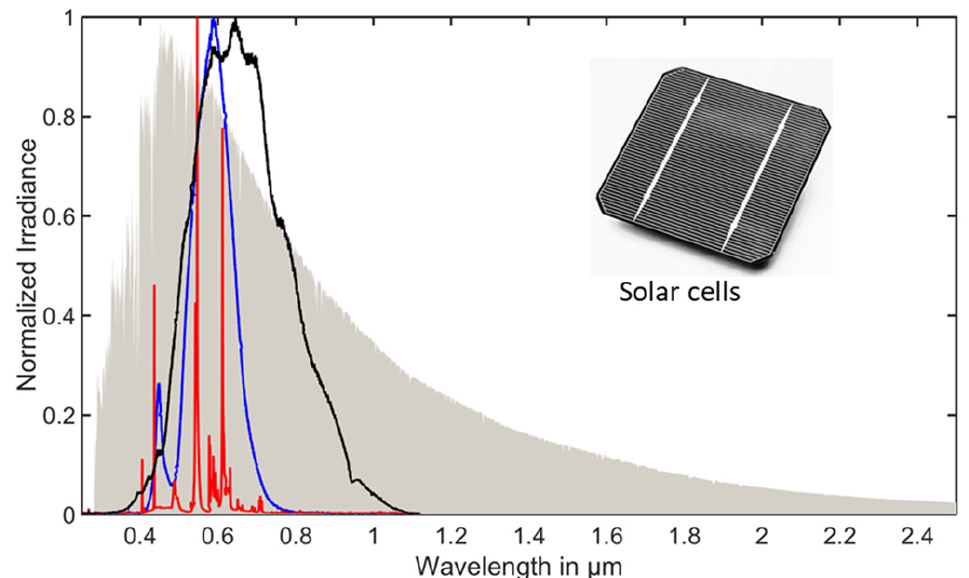
Figure 4. Normalized irradiance of a halogen lamp (black), an LED lamp (blue), and a fluorescent lamp (red) [21] compared to the AM0 spectrum (gray). (Note that the amplitude has been normalized for better visibility and spectral comparison).